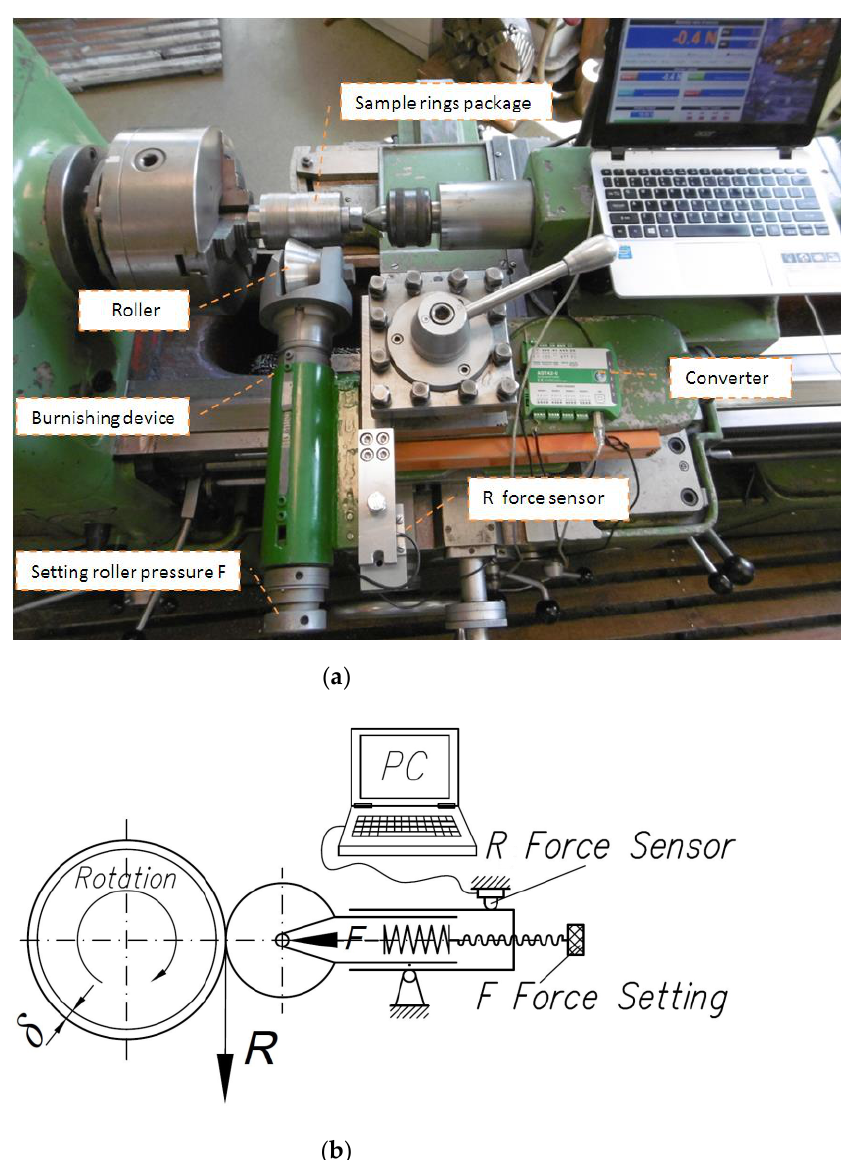
Figure 5. ( a )Photographand( b Figure 5. ( a ) Photograph and ( b ) schematic diagram of the stand used for testing the roller bur- nishing process.